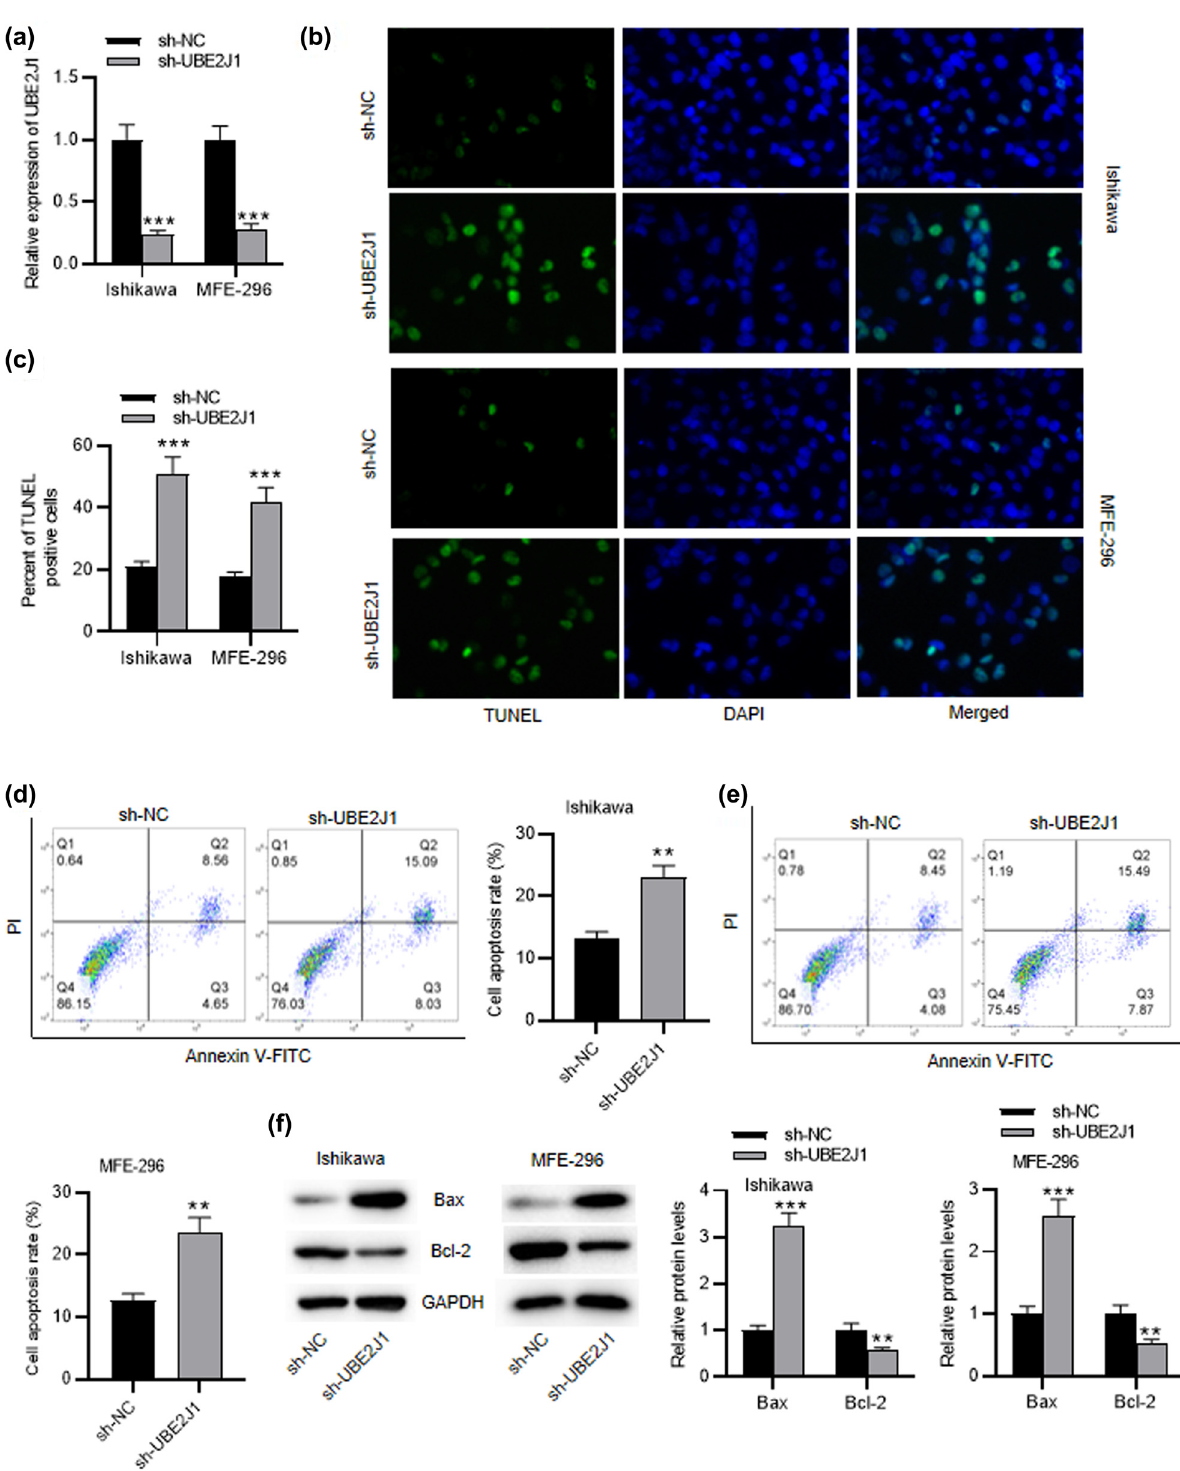
Figure 1: UBE2J1 knockdown promotes cell apoptosis in EC. Ishikawa and MFE - 296 cells were transfected with sh - NC or sh - UBE2J1. ( a ) Expression of UBE2J1 in Ishikawa and MFE - 296 cells was evaluated by RT - qPCR. ( b and c ) TUNEL assay and ( d and e ) fl ow cytometry analysis were adopted to measure cell apoptosis. ( f ) Protein levels of apoptosis markers, Bcl - 2, and Bax, in EC cells were analyzed by western blot. Bar graphs were used to represent the data. ** p < 0.01, *** p <